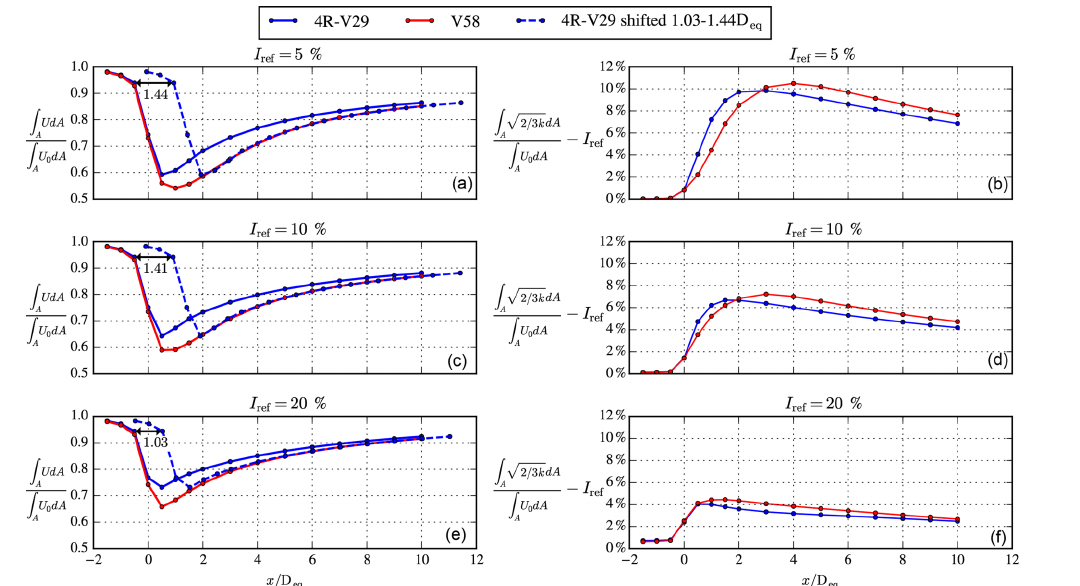
Figure 18. RANS predicted wake recovery of a simplified 4R-V29 multi-rotor wind turbine compared with an equivalent V58 single-rotor wind turbine for three difference turbulence intensities. (a, c, e) Integrated stream-wise velocity; (b, d, f) integrated added turbulence intensity. The dashed blue line is the integrated stream-wise velocity of the simplified 4R-V29 wind turbine shifted by